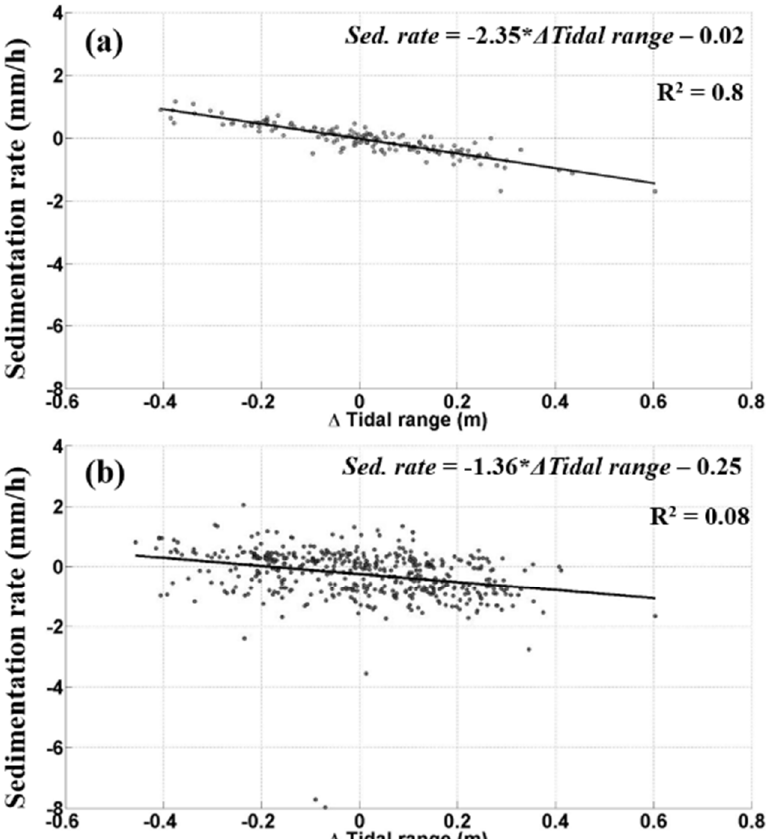
Figure 9. Sedimentation rate (mm h − 1 ) as a function of tidal range variation within ( a ) Spartina anglica and ( b ) Spartina maritima . Solid line corresponds to linear regression expressed by the equations y = − 2.35x − 0.02 (R 2 = 0.8, n = 168, p < 0.001) for S. anglica and y = − 1.36x − 0.25 (R 2 = 0.08, n = 472, p < 0.001) for S. maritima (with significance threshold at p = 0.05).